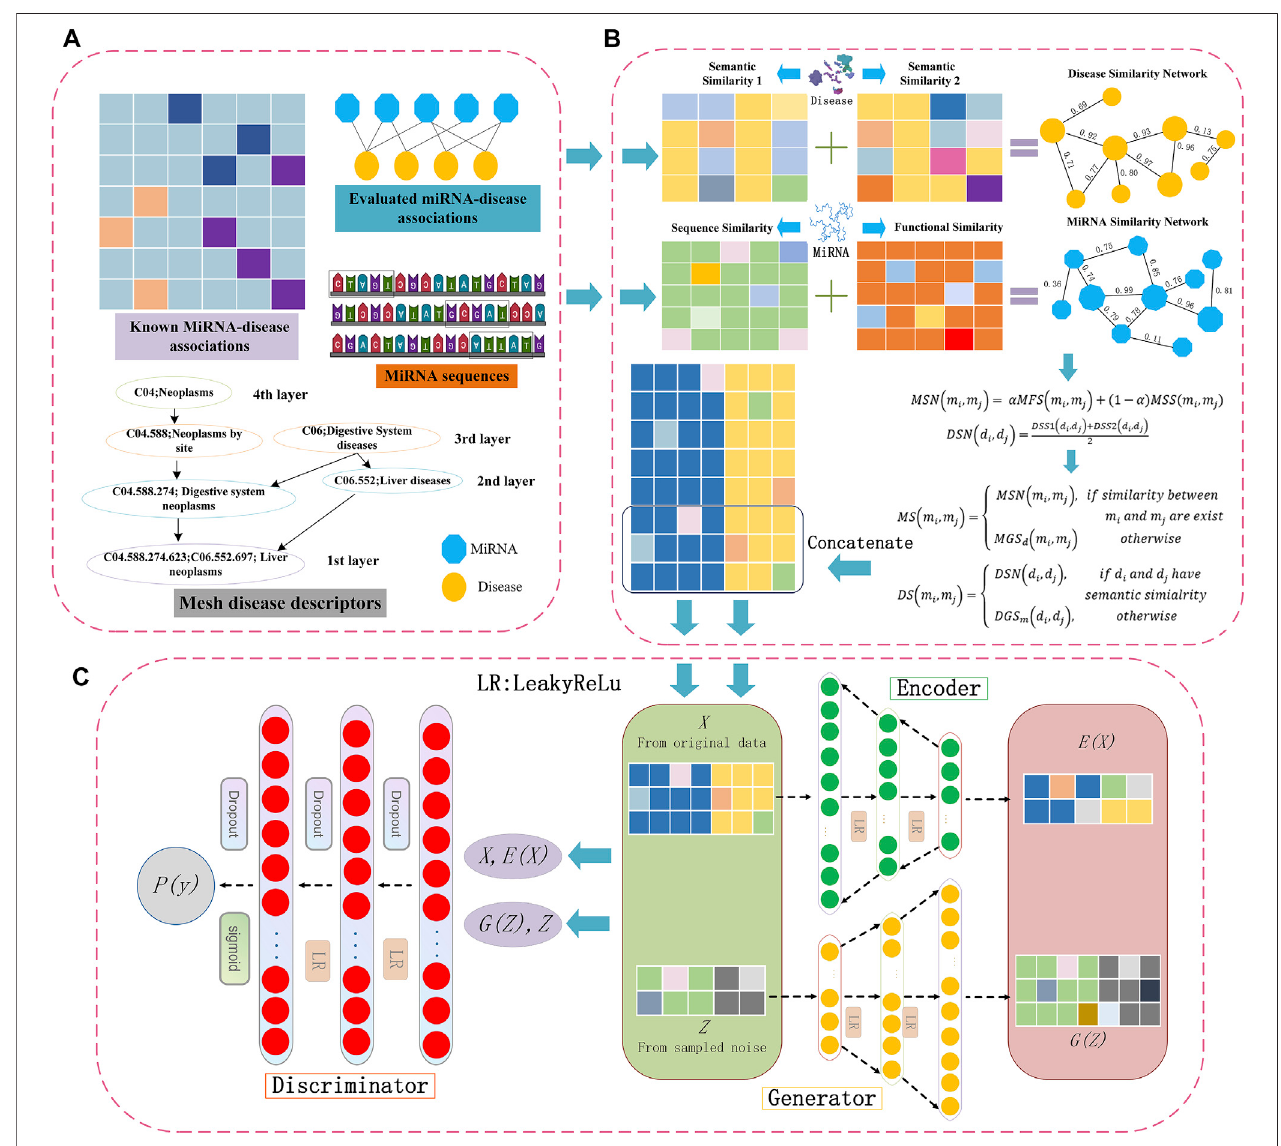
FIGURE 1 | Flowchart of potential miRNA-disease association prediction based on the BGANMDA model, (A) is the multi-source information of miRNAs and diseases, (B) is the details of constructing both miRNAs and diseases similarity network, and (C) is the structure of BGANMDA.